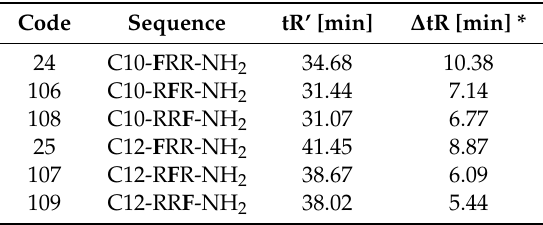
Table 1. Retention time of peptides 24 , 25 , 106 – 109